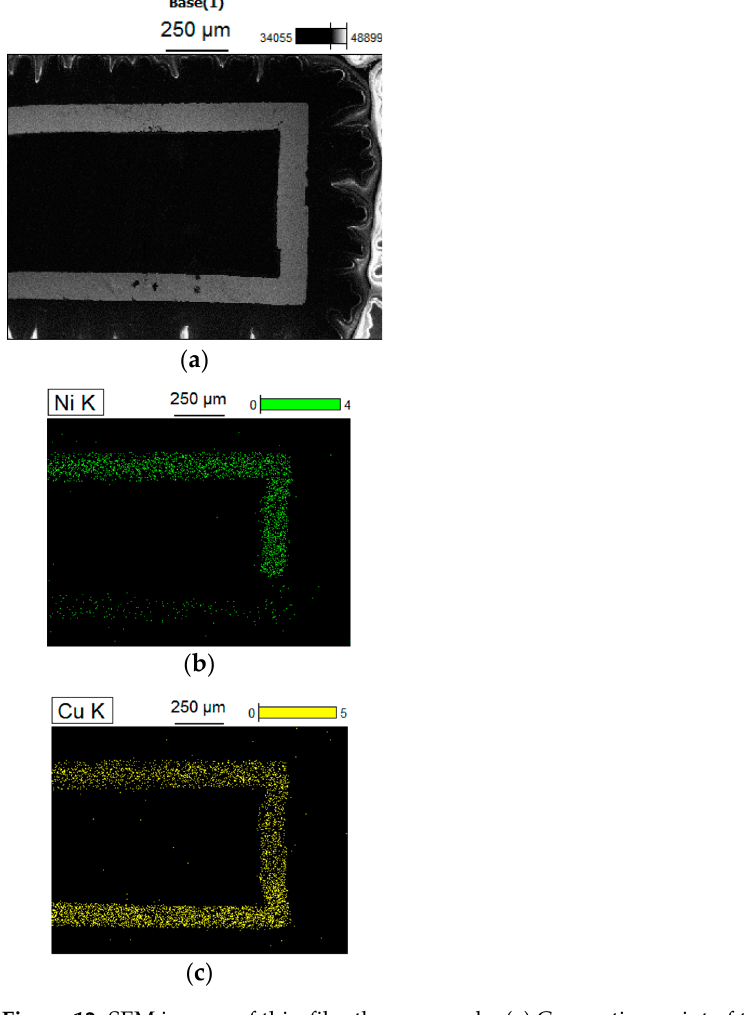
Figure 12. SEM images of thin-film thermocouple. ( a ) Connection point of thermocouple. ( b ) Distri- bution of Ni. ( c ) Distribution of Cu.